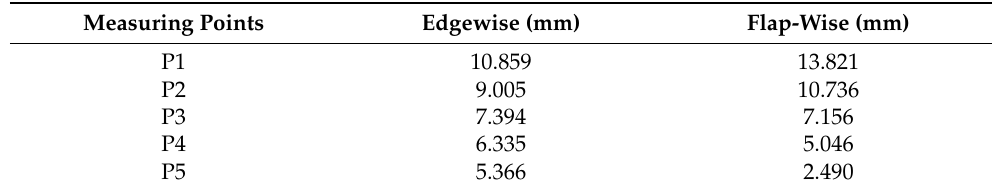
Table 3. Blade displacement peak value monitored in the whole field.